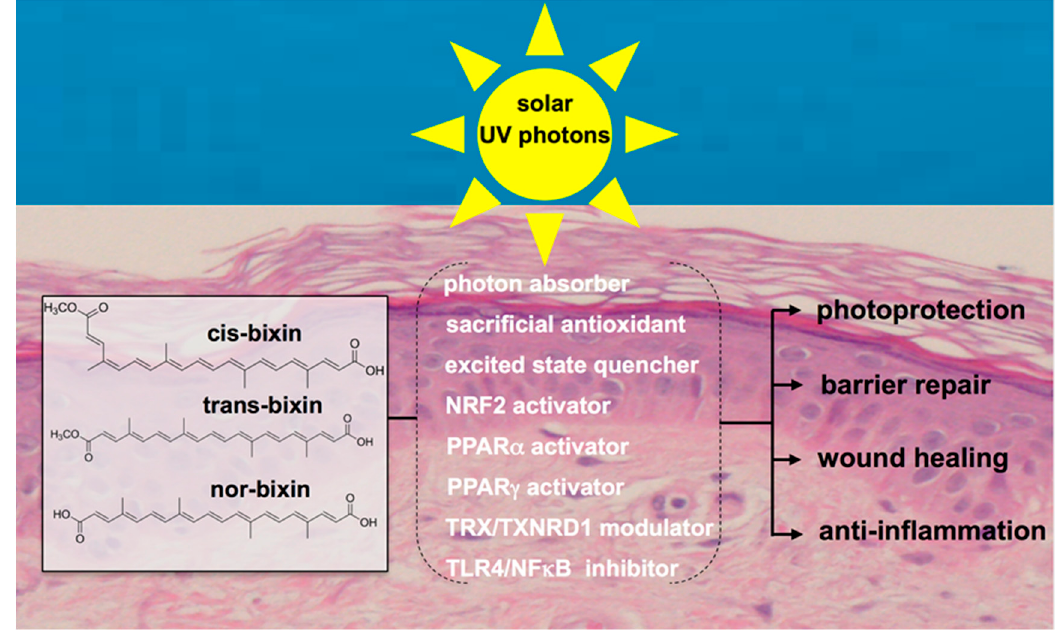
Figure 2. Bixin for improved skin barrier function and photoprotection. Based on pleiotropic activities including direct chemical and NRF2-dependent antioxidant modulation, cis-bixin and its physiologically relevant derivatives trans-bixin and nor-bixin enhance skin barrier structure and function with photoprotective and potentially photochemopreventive efficacy; thioredoxin (TRX), thioredoxin reductase 1 (TXNRD1).